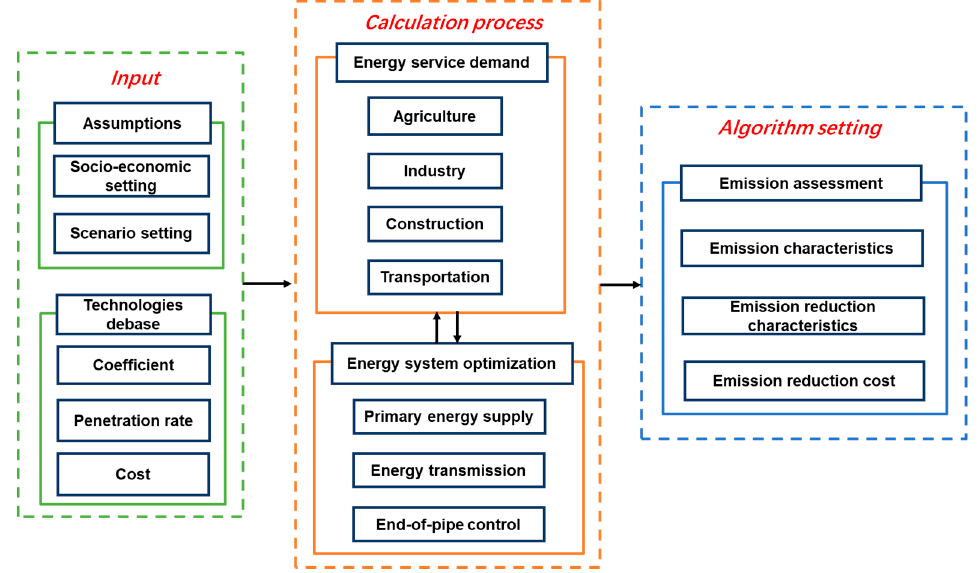
Figure 1. Structure of the power industry air pollutant emission reduction model.